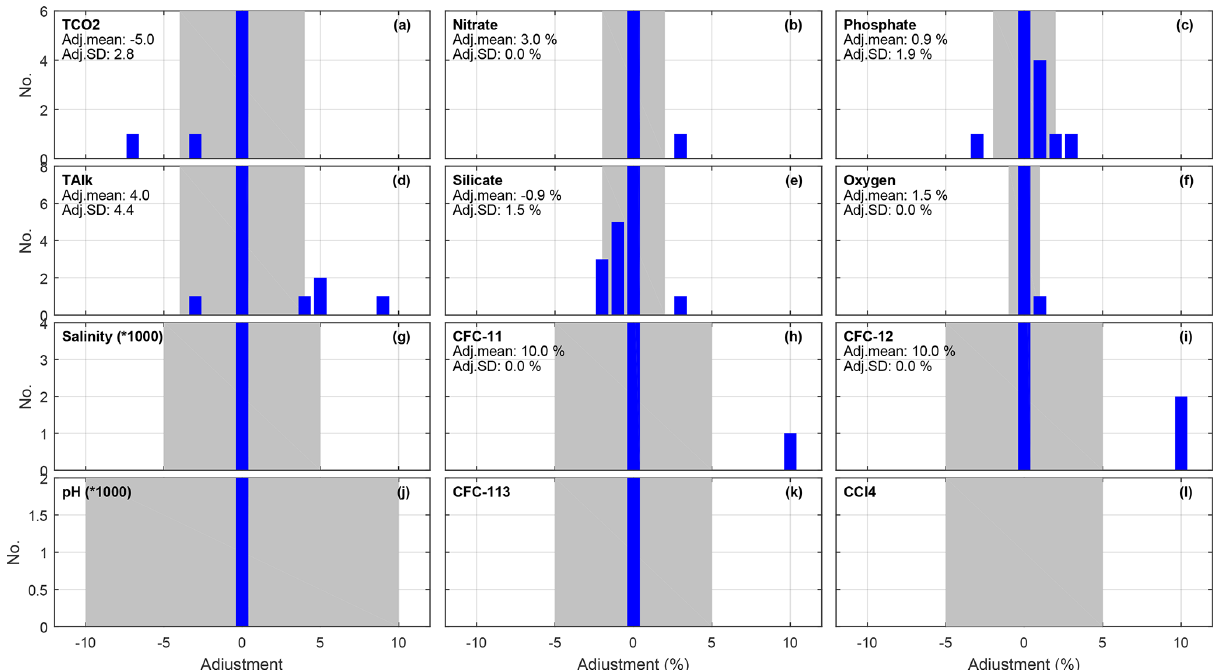
Figure 6. Distribution of applied adjustments for each core variable that received secondary QC, in micromoles per kilogram for TCO 2 and TAlk and unitless for salinity and pH (but multiplied with 1000 in both cases so a common x axis can be used), while for the other properties adjustments are given in percent ((adjustment ratio − 1) × 100)). Grey areas depict the initial minimum adjustment limits. The figure includes numbers for data subjected to secondary quality control only. Note also that the y axis scale is set to render the number of adjustments to be visible, so the bar showing zero offset (the 0bar) for each variable is cut off (see Table 6 for these numbers). Table 6. Summary of secondary QC results for the 106 new cruises, in number of cruises per result and per variable. Sal. Oxy.